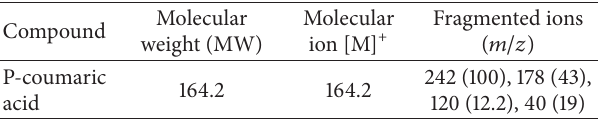
Figure 2: UV absorption spectrum of P-coumaric acid in methanol (isolated from methanolic extract by preparative TLC). Table 1: Molecular weights (MW) and important ions present in the mass spectra of P-coumaric acid in the examined plant extracts by ESI-MS.